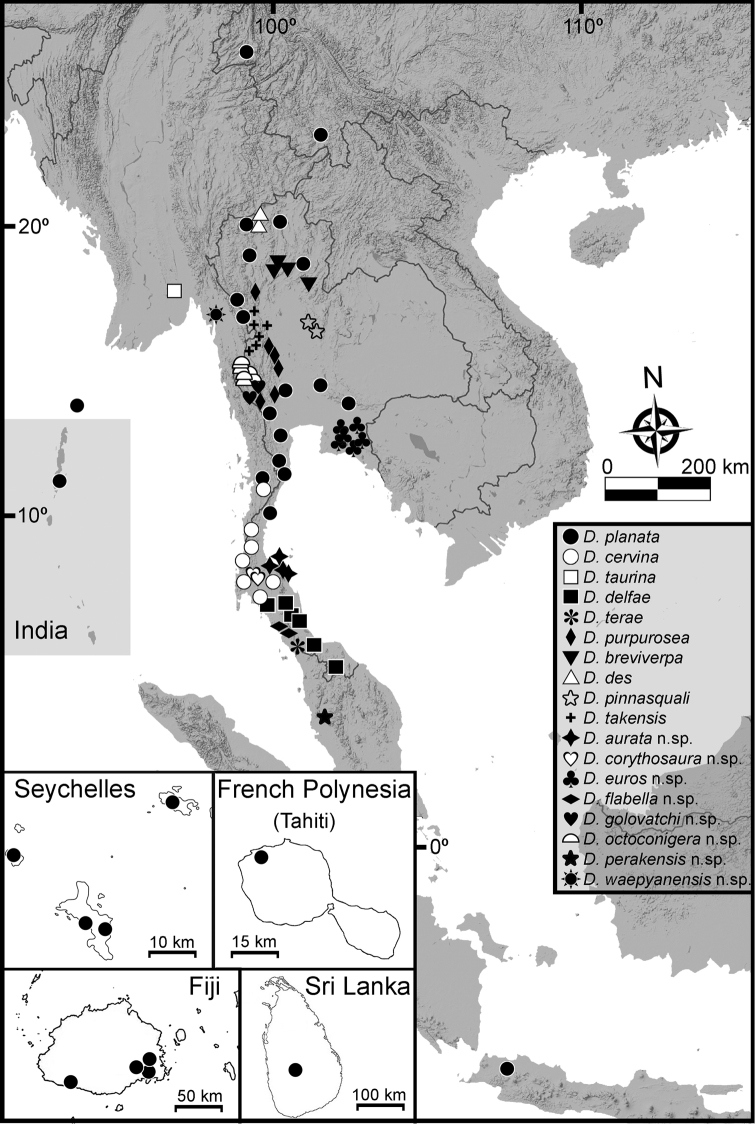
Known distribution of all Desmoxytes species based on all recorded data (D.
planata, D.
cervina and D.
delfae are shown in the representative localities).